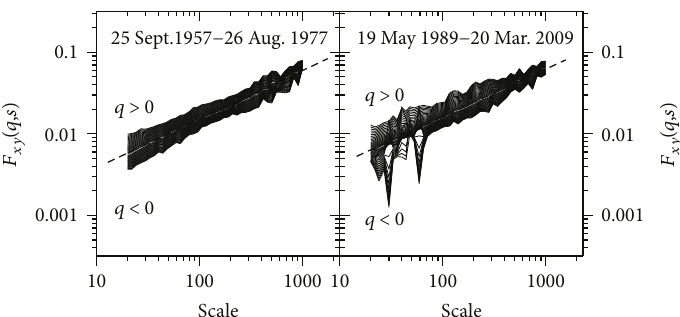
Figure 7: Cross-correlation fl uctuation functions between the S&P500 and NASDAQ calculated according to (5) for − 4 ≤ q ≤ 4 in two periods: September 25, 1957 – August 26, 1977, and May 19, 1989 – March 20, 2009.